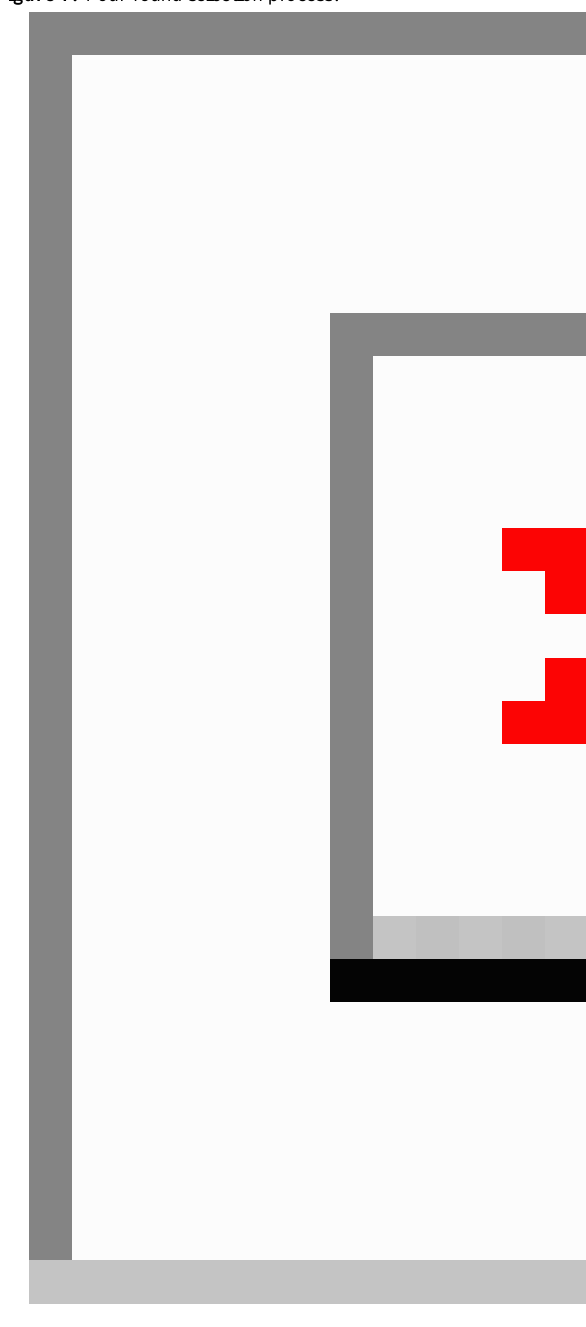
Figure 1. Four-round selection